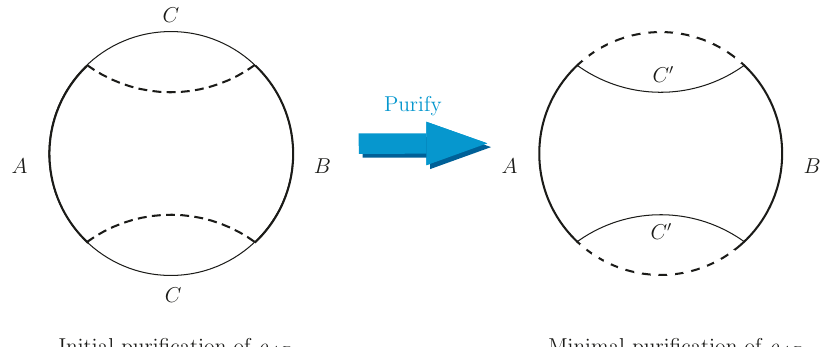
Figure 3 . Left: a pure state j (cid:9) i ABC as the initial puri(cid:12)cation state of (cid:26) AB that lies on the conformal boundary. Right: the minimal entanglement puri(cid:12)cation of (cid:26) AB , j (cid:9) i ABC 0 lying on the boundary of the entanglement wedge r AB . To compute E P ( A : B ), we will restrict the bulk region to the entanglement wedge r AB